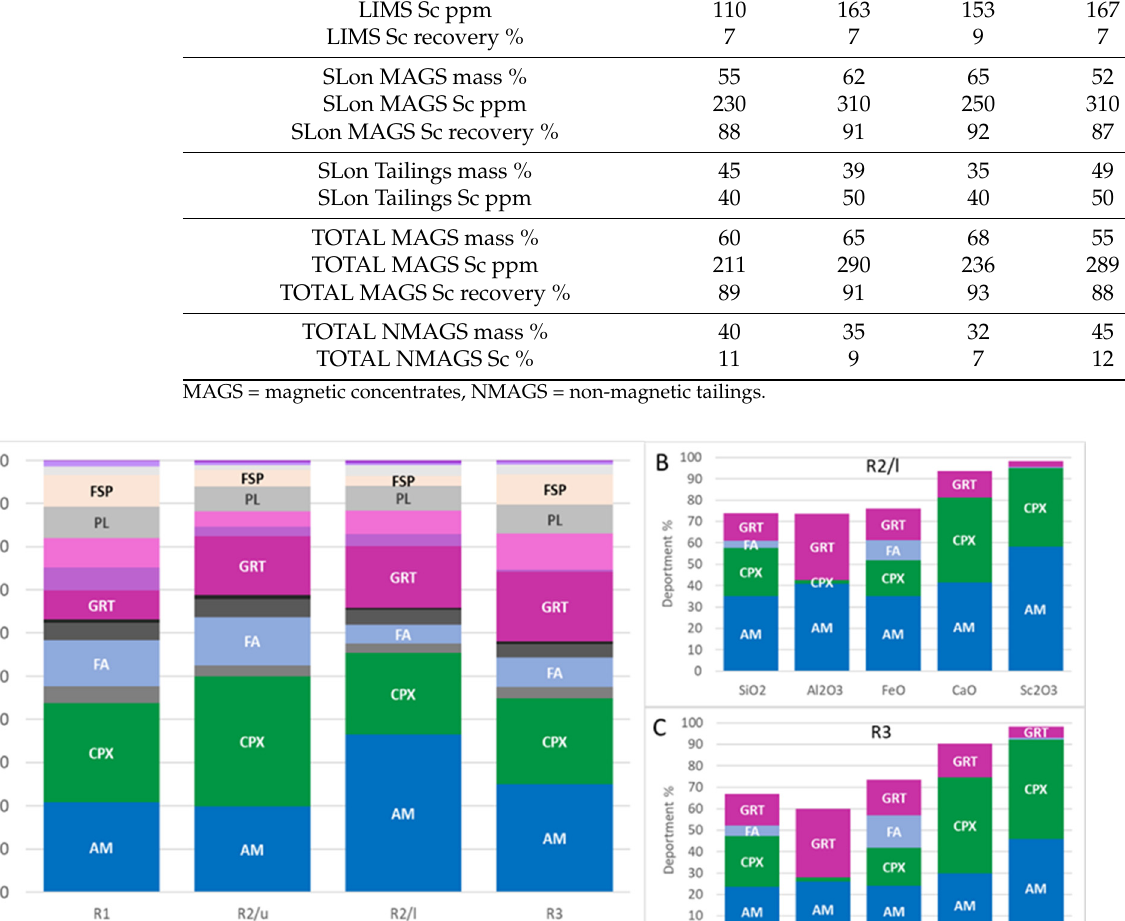
Table 2. Details of the selected concentrates processed with LIMS and SLon using composite samples R1, R2/u, R2/l (R2 upper and lower sample), and R3. Drill Core Sample R1 R2/u R2/l Feed ppm Sc 150